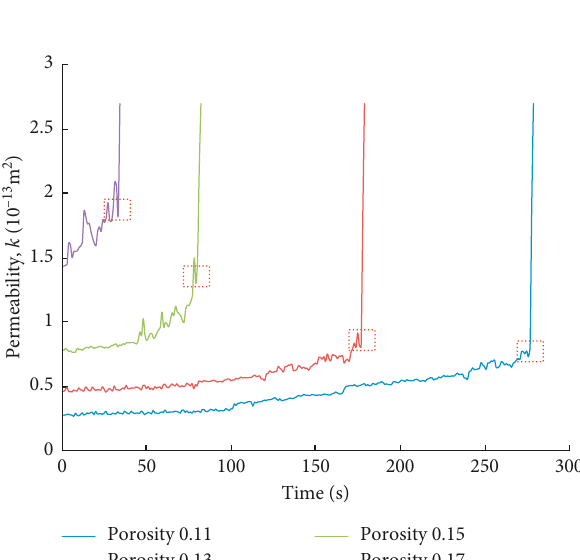
Figure 5: Permeability-time curves of tested specimens cemented by clay (the red rectangles mark seepage stability).